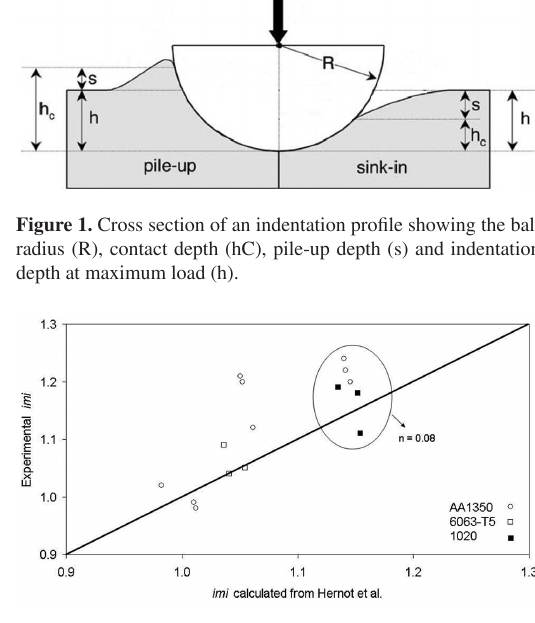
Figure 2. Experimental values of imi from indentation profiles versus values calculated using the model described by Hernot et al. 1